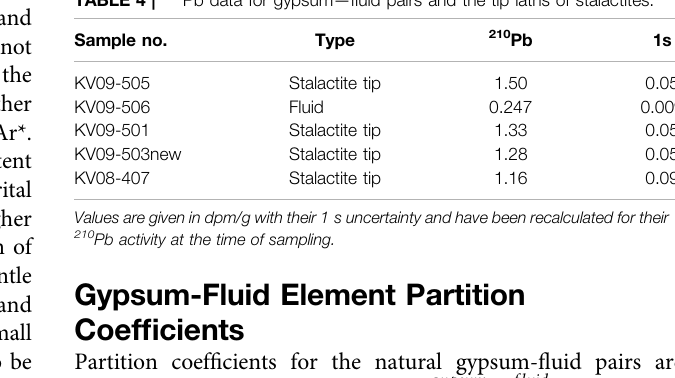
TABLE 3 | 210 Pb data for growth horizons in the gypsum section (KV09-507) and the 1-year growth (KV09-503), and the noble gas corrected apparent ages for these samples. Not analysed — n.a. Sample no.